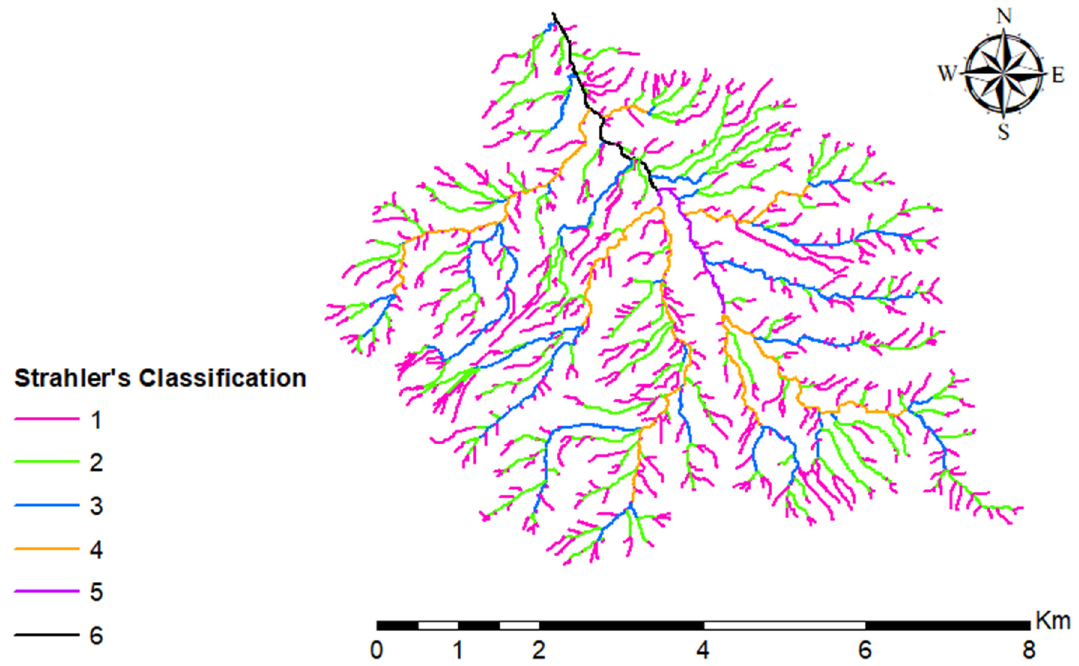
Figure 6. Strahler classification (Source: Authors by ESRI ArcGIS, 2020). Table 2. Precipitation parameters.